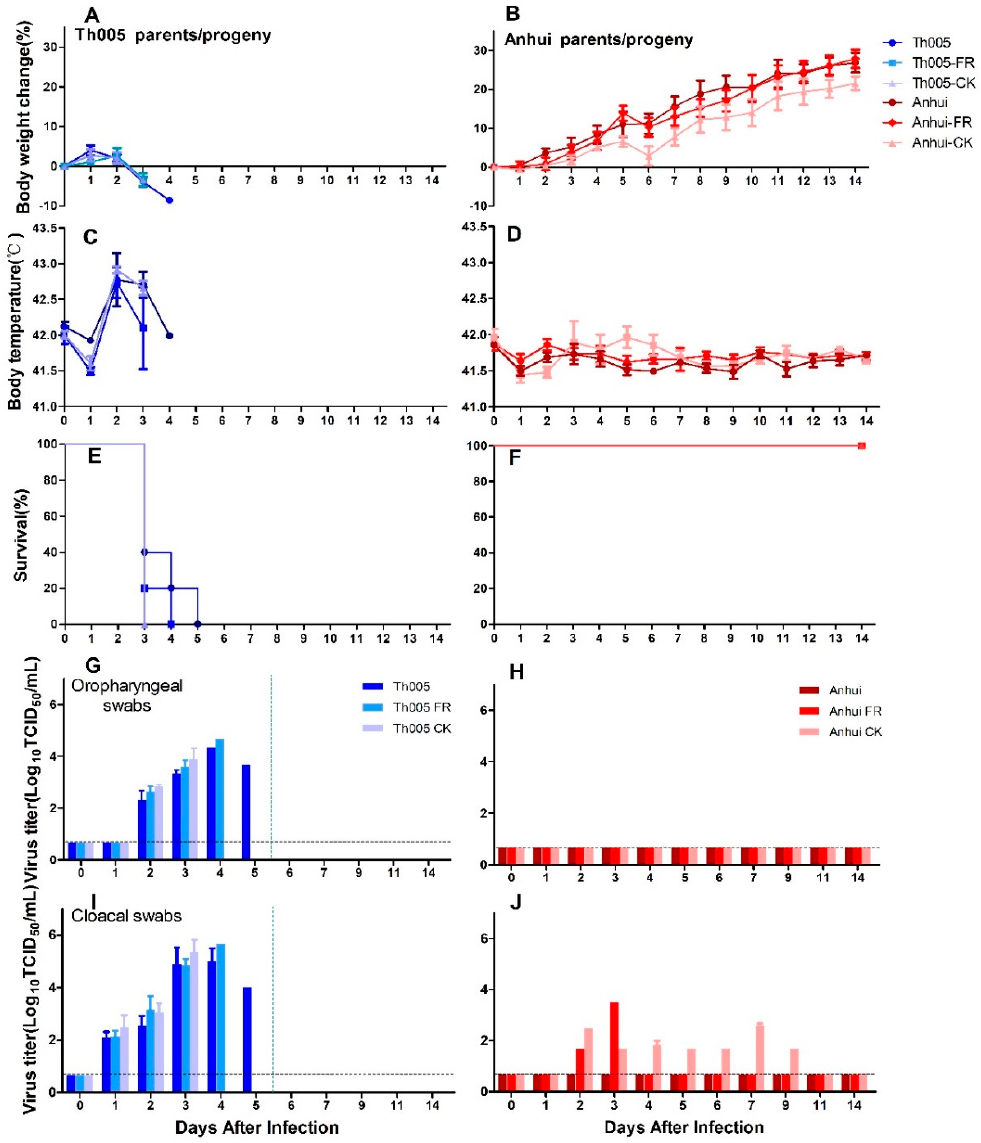
Figure 3. Pathogenicity of Th005, Th005 FR, Th005 CK, Anhui, Anhui FR, and Anhui CK infection in chickens. Body weight change rate: ( A )Th005, Th005 FR, and Th005 CK. ( B ) Anhui, Anhui FR, and Anhui CK. Body temperature: ( C )Th005, Th005 FR, and Th005 CK. ( D )Anhui, Anhui FR, and Anhui CK. Survival rate: ( E )Th005, Th005 FR, and Th005 CK. ( F ) Anhui, Anhui FR, and Anhui CK. Viral titers in oropharyngeal swabs from chickens: ( G )Th005, Th005 FR, and Th005 CK. ( H )Anhui, Anhui FR, and Anhui CK. Viral titers in cloacal swabs from chickens: ( I ) Th005, Th005 FR, and Th005 CK. ( J )Anhui, Anhui FR, and Anhui CK. The results are displayed as means and SD from duplicates from five independent chickens.